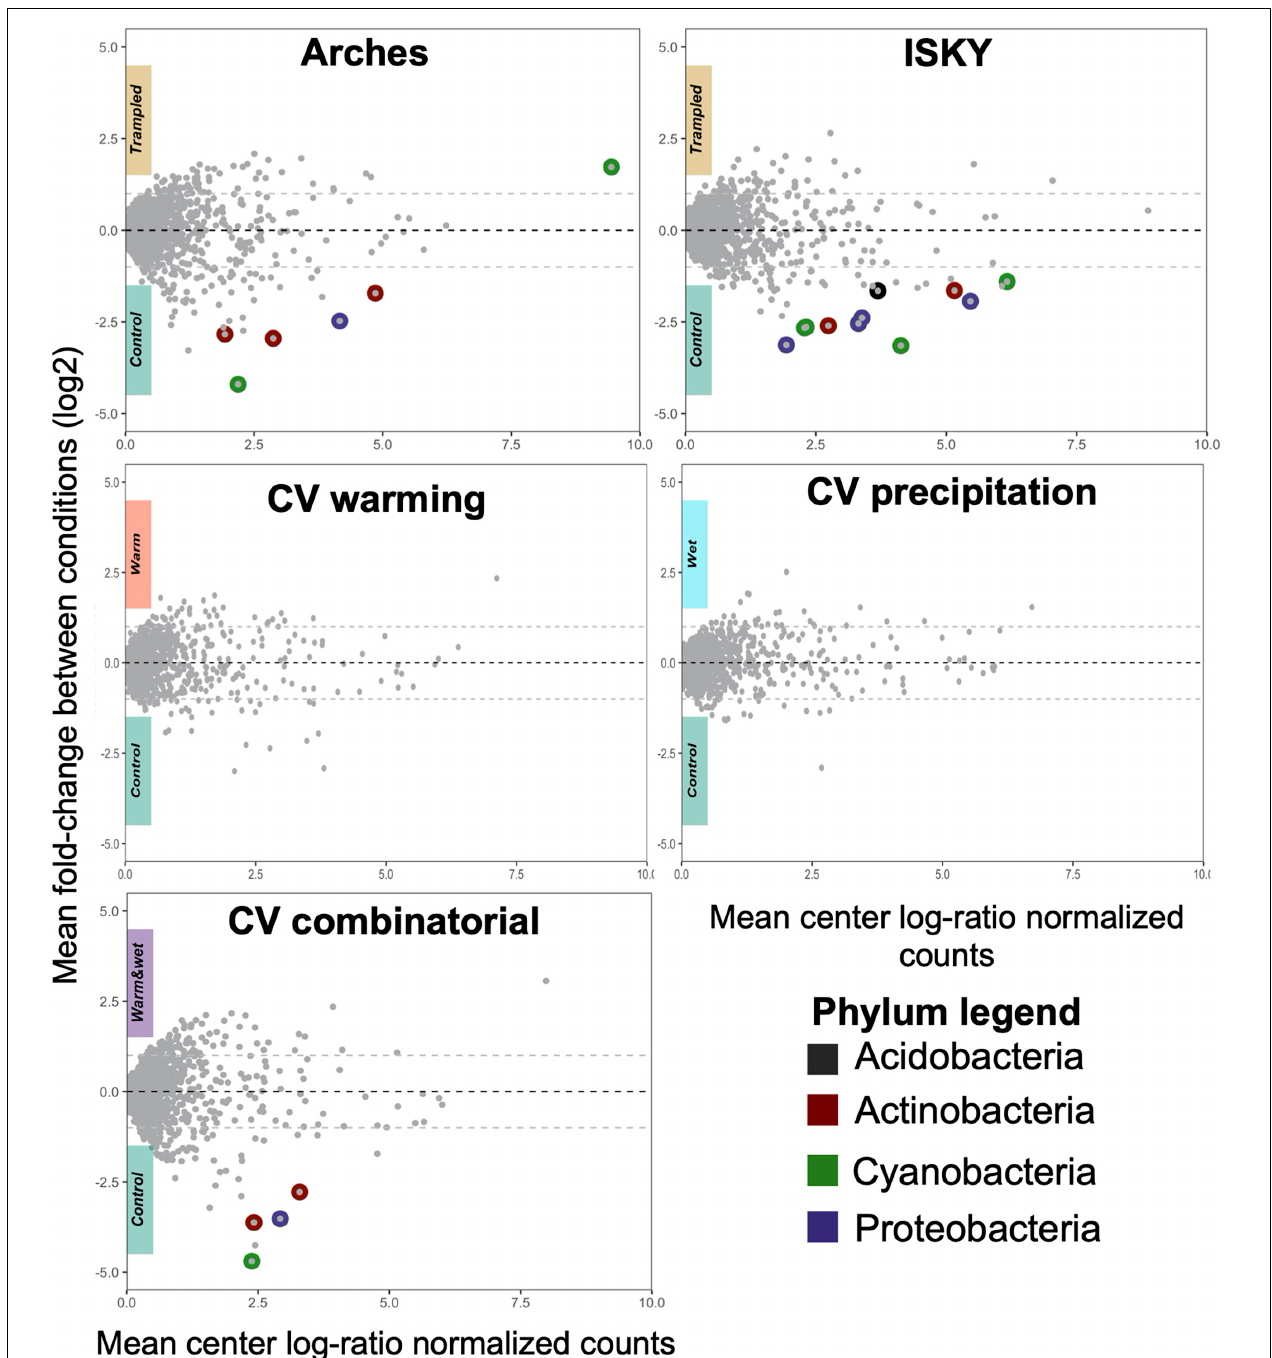
FIGURE 4 | Differentially abundant ASVs due to treatment. Each panel represents a Bland-Altman plot for the abundance and fold change of each ASV in the dataset. The x -axis indicates the center log-ratio normalized counts of each ASV in the data, while the y -axis shows the fold-change in relative abundance due to the treatments. ASVs that showed a statistically significant difference in relative abundance are highlighted by colors representing the Phylum to which they belong. A full list of the differentially abundant ASVs is listed in Supplementary Table 2 .